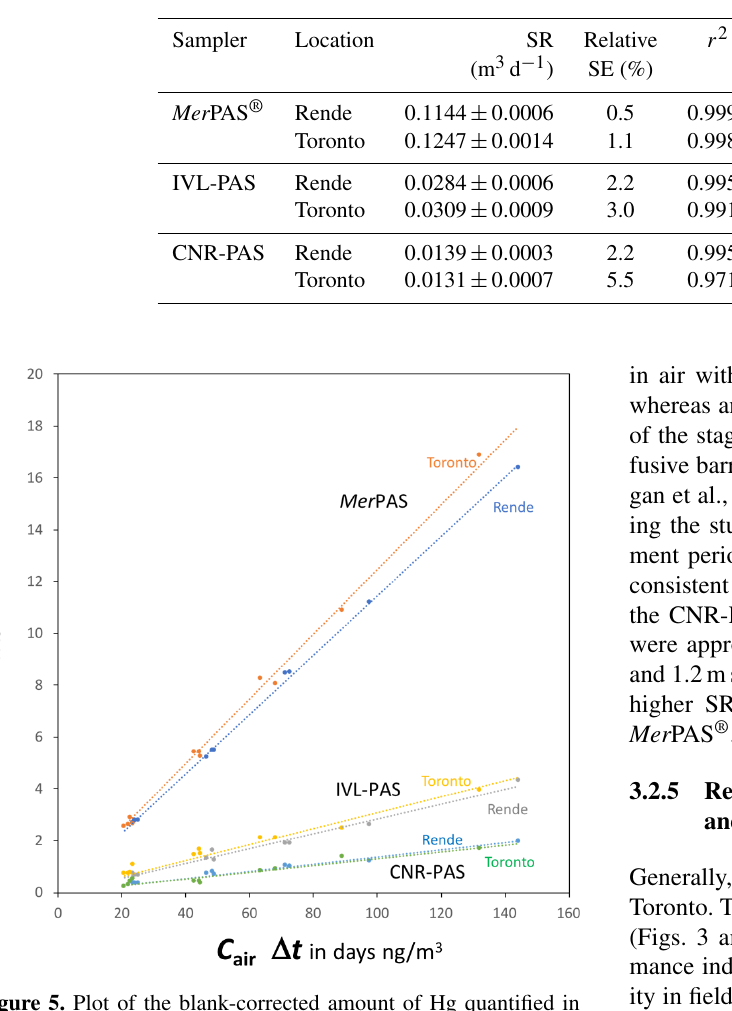
Table 3. Results of the linear regressions displayed in Fig. 5. The slope of the regression line corresponds to the sampling rate of a passive air sampler.